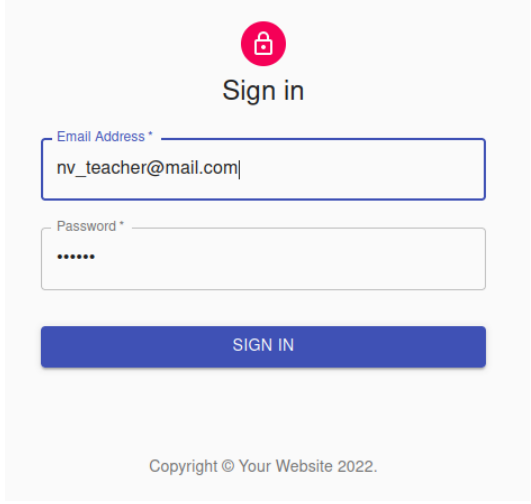
Figure 3. Arion Platform login form.